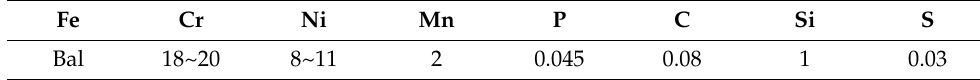
Table 2. Chemical composition of 304 stainless steel